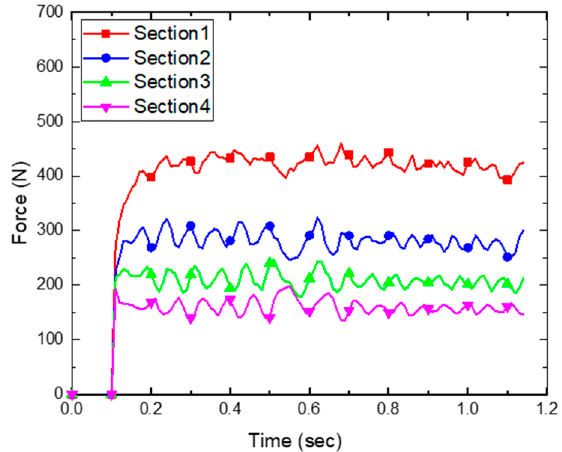
Figure 19. History of total normal forces in each section.